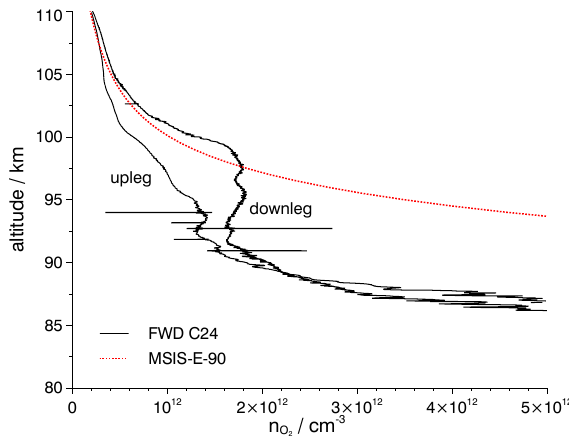
Figure 13. Profile for the O 2 ( + O) number density from fore sensor C24 after aerodynamic correction (ram for upleg, wake for down- leg) compared to